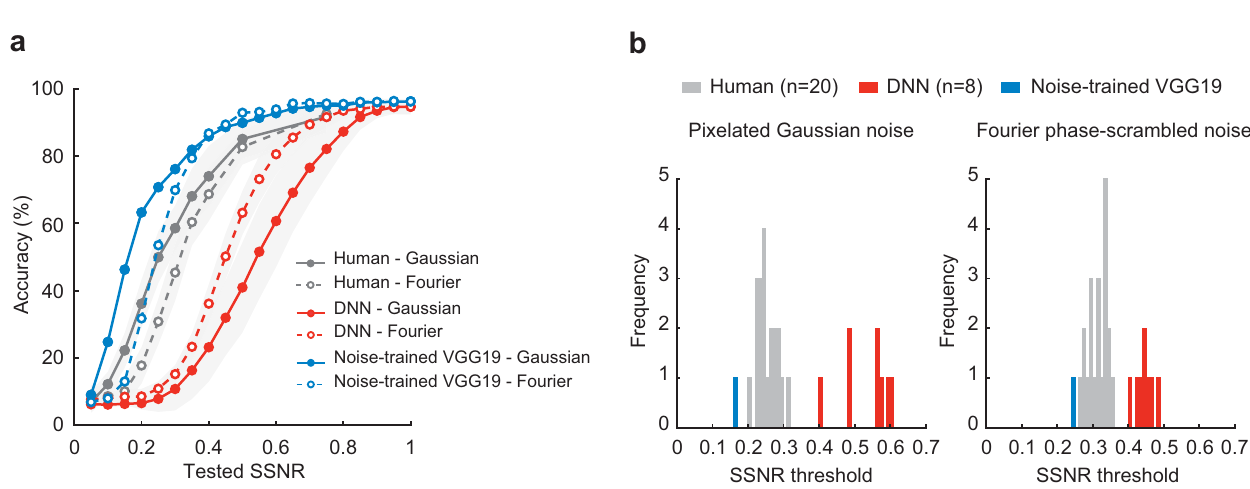
Fig 4. Noise-trained VGG-19 outperforms human observers and other DNNs. (a) Mean classification accuracy of noise-trained VGG-19 (blue), human observers (gray), and pretrained DNNs (red) for objects in pixelated Gaussian noise (solid lines, closed circles) and Fourier phase-scrambled noise (dashed lines, open circles). Noise-trained VGG-19 was trained with objects in Gaussian noise, Fourier phase-scrambled noise, and clean images from the 16 categories. (b) Frequency histograms comparing the SSNR thresholds of noise-trained VGG-19 (blue), individual human observers (gray), and 8 standard pretrained DNNs (red). Data are available at https://osf.io/bxr2v/. DNN, deep neural network; SSNR, signal-to-signal-plus-noise